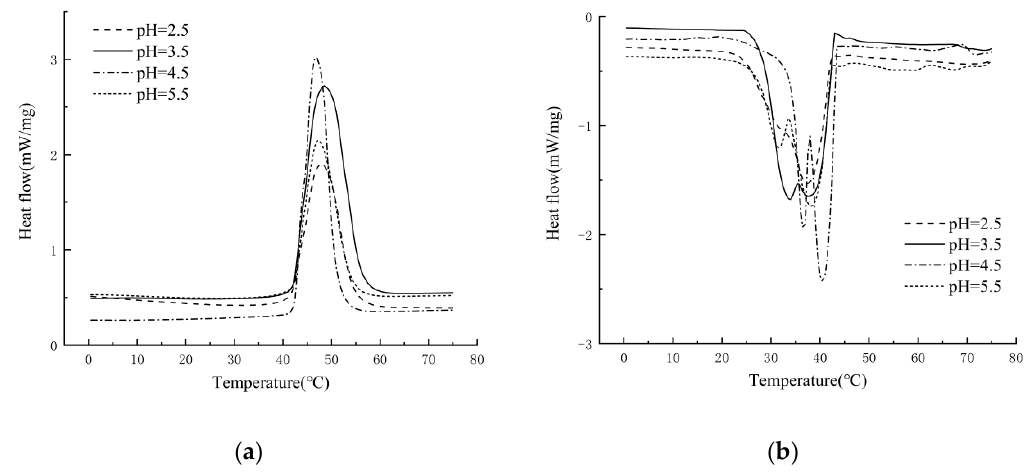
Figure 7. DSC curves of MPCMs prepared at different pH in the SDS ratio of 0.22%, ultrasonic oscillation time of 10 min, core–shell ratio of 1:1. ( a ) Melting and ( b ) crystallization processes at a temperature rate of 10 K/min in a 60 L/min flow of N 2 . Table 7. Experimental results for changing pH value.